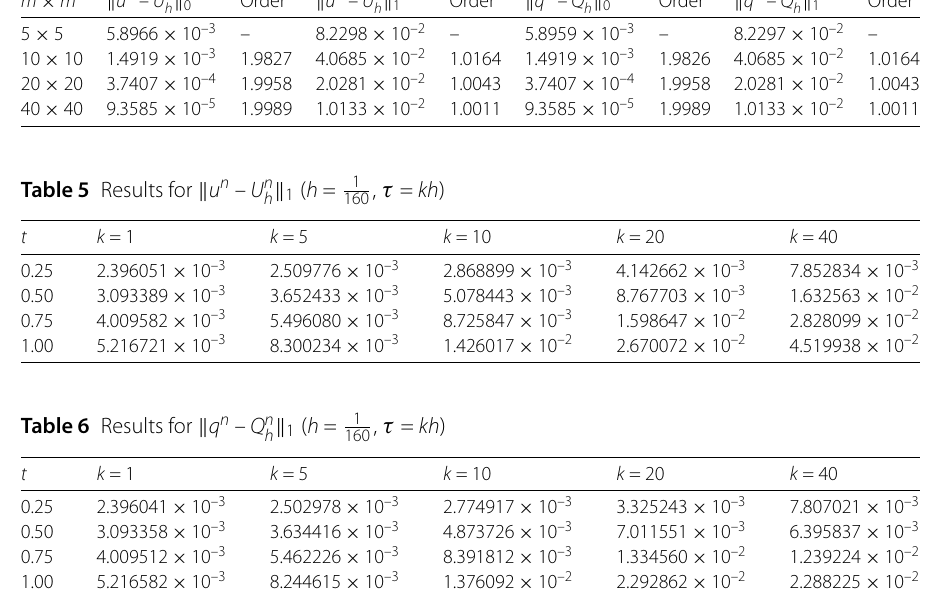
Table 4 Results for U n